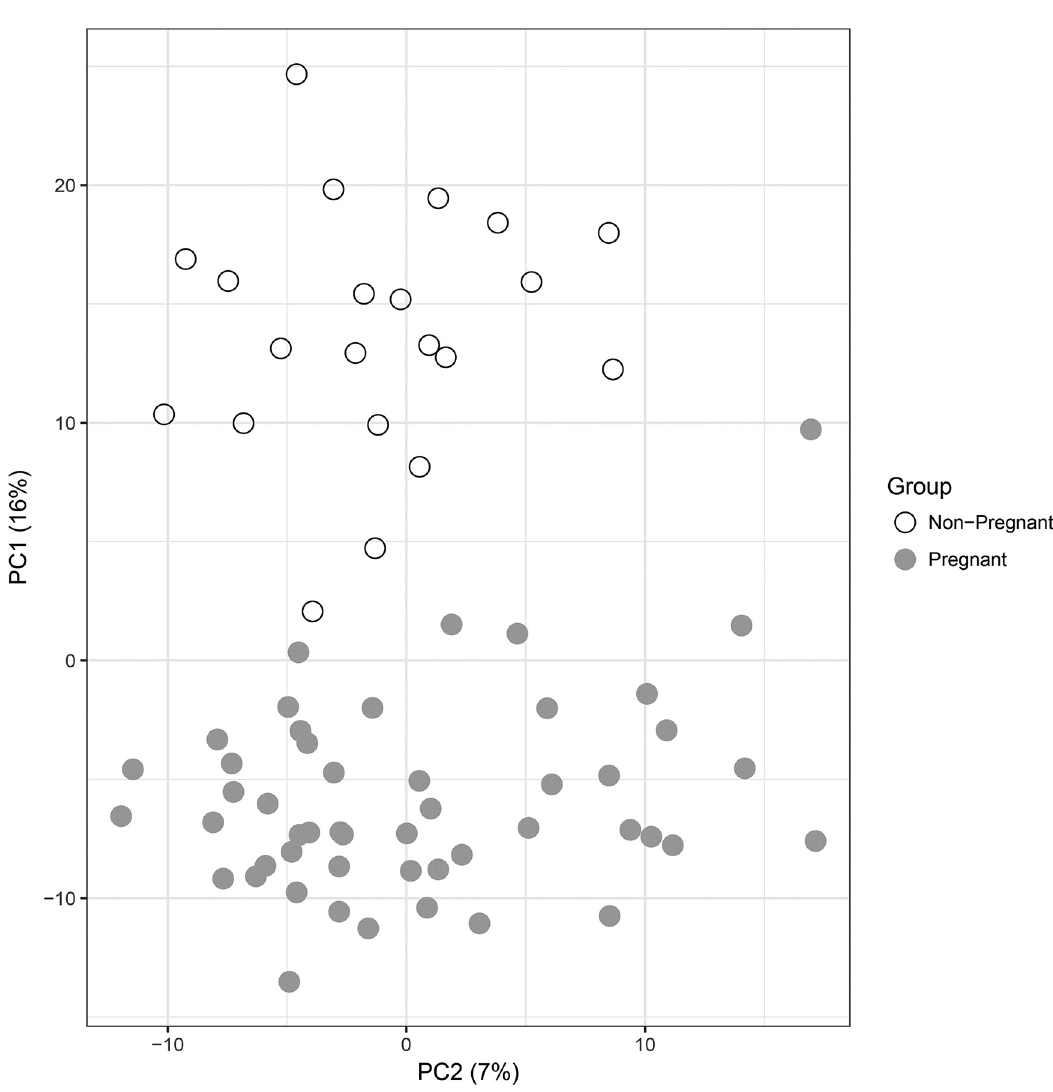
Fig 1. Principal component analysis of metabolic profiles of pregnant and non-pregnant women. Principal components (PC1, PC2) are derived from abundance of 637 metabolites measured in plasma samples of 50 pregnant and 21 non-pregnant women. The percentage of the variance explained by each principal component is shown in